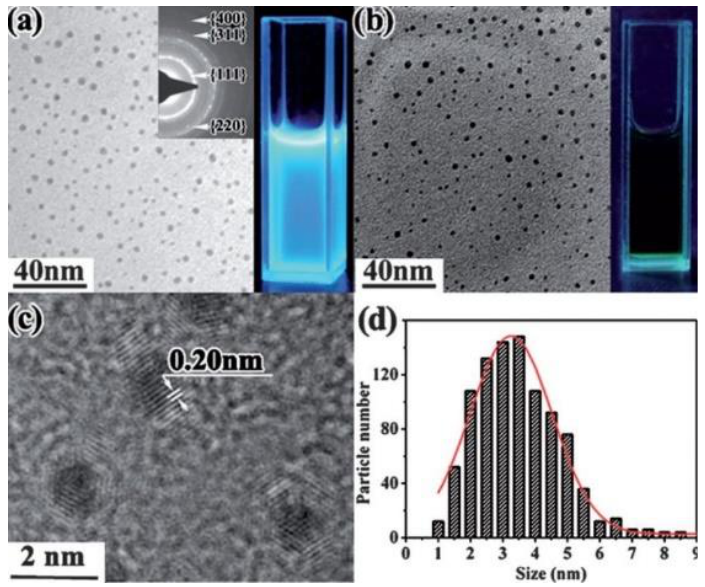
Figure 28. TEM images of CNPs prepared in ( a ) PEG and ( b ) water. ( c ) HRTEM of CNPs prepared in PEG and ( d ) their size distribution. Reprinted with permission from Ref. [110]. 2009, Royal Society of Chemistry.